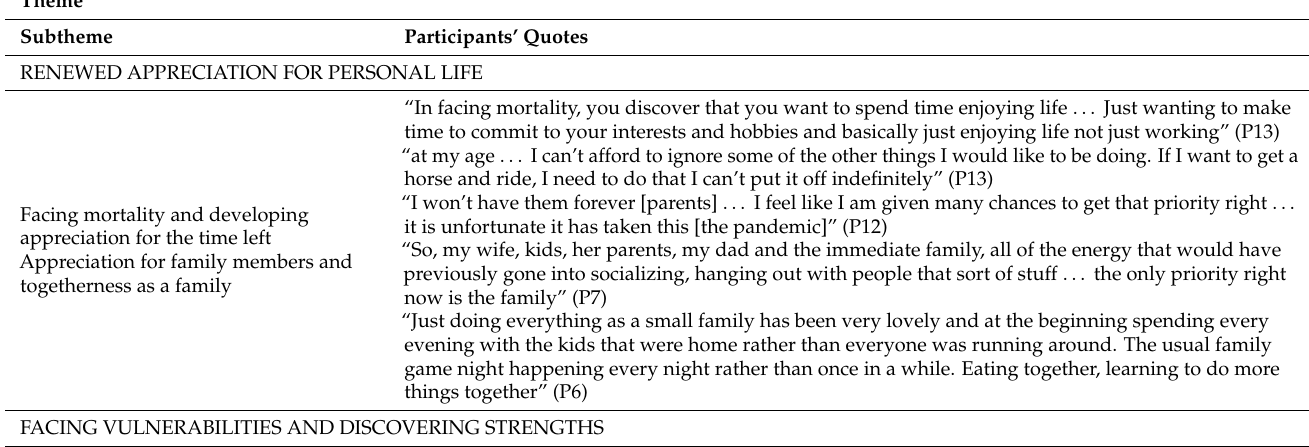
Table 2. Overarching themes, subthemes, and associated quotes highlighted from the physicians’ experiences of the COVID-19 pandemic in response to the question, “How is the experience of the pandemic affecting you personally and